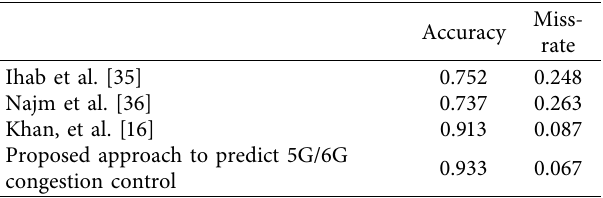
Table 9: Comparison of the proposed approach with previous research